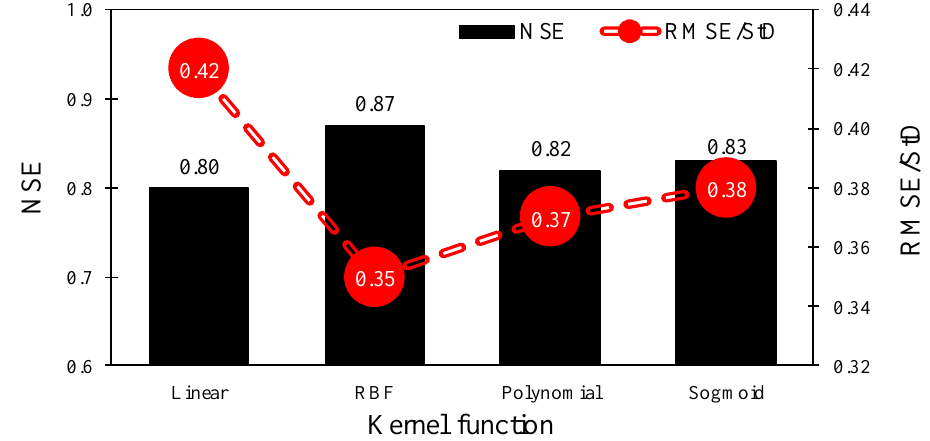
Figure 4. Statistical performance of the results obtained from the support vector regression (SVR) model with different kernel-types (linear, polynomial, sigmoid, and radial basis function) for prediction of the total sediment load (TSL) in rivers (Noted that all the models performed with the default values and without the optimization process).